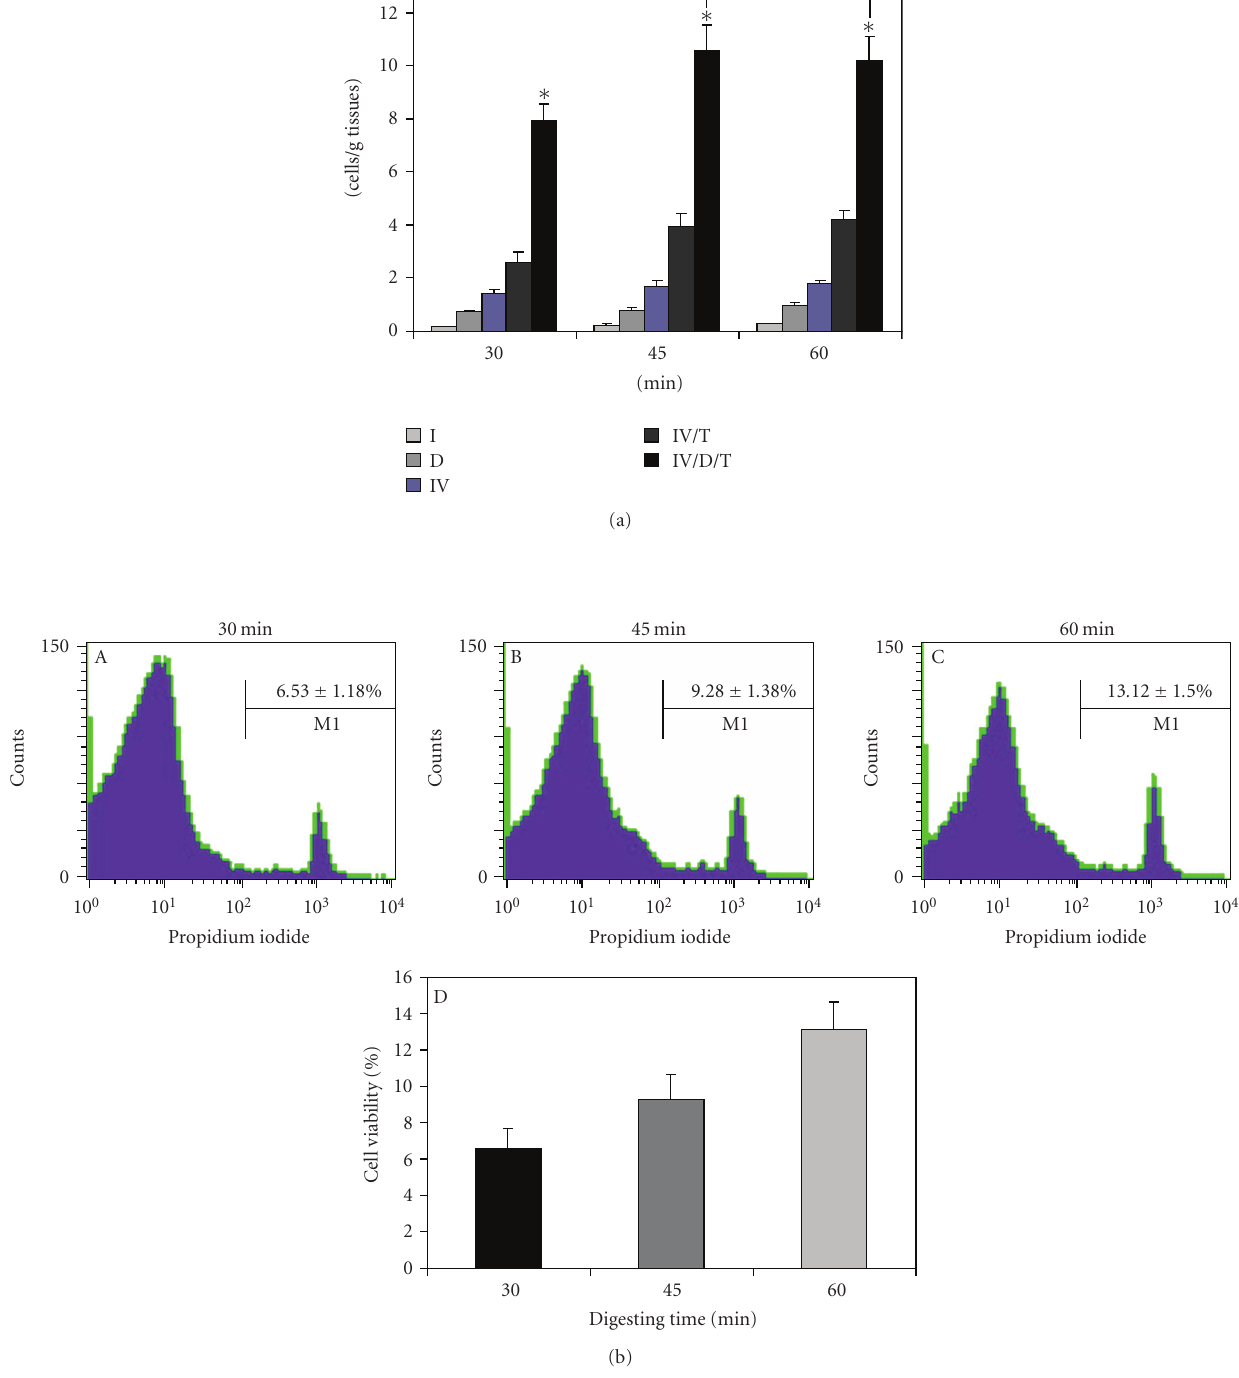
Figure 1: (a) Comparisons between di ff erent methods in nucleated cell yield within one hour’s digest ( n = 6 for each group). $: no significant di ff erence, P > . 05; ∗ : P < . 01 compared with all other groups in the same digest time. (b) Representative images of cell viability analysis. Newly isolated cells from rat brown adipose were stained with Propidium iodide and then analyzed using flow cytometry. A: Cell viability after 30 minutes digestion with collagenase IV, dispase II, and trypsin; B: cell viability after 45 minutes digestion with collagenase IV, dispase II, and trypsin; C: cell viability after 60 minutes digestion with collagenase IV, dispase II, and trypsin; D: Comparison of cell viabilities after digesting for di ff erent time with collagenase IV, dispase II, and trypsin, ( n = 6 for each